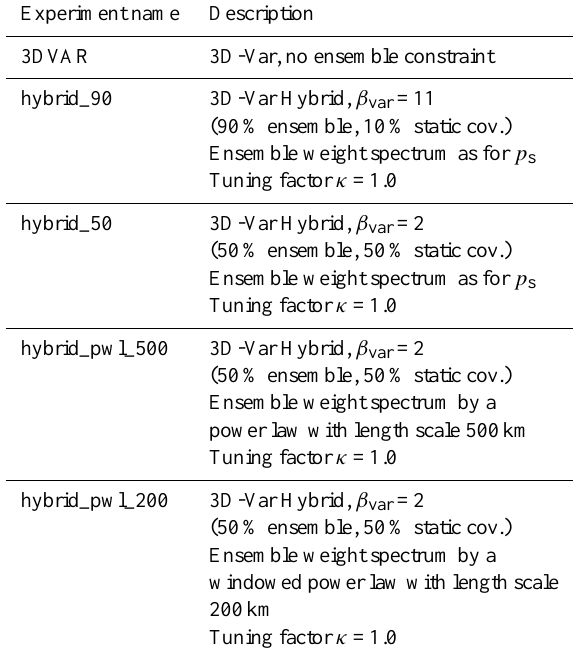
Table 1. Description of experiments carried out with the HIRLAM Hybrid variational ensemble data assimilation for the period 12– 24 August 2007.